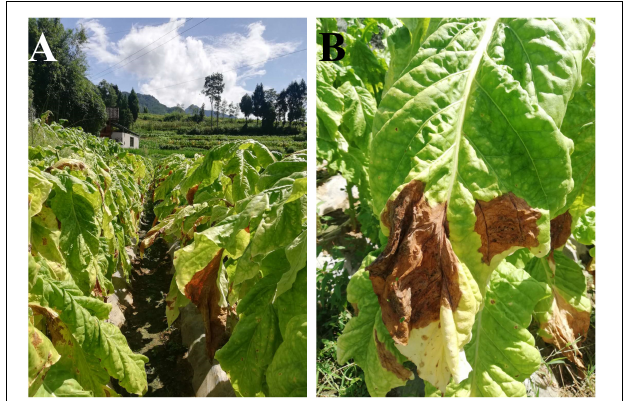
FIGURE 1 | Field symptoms of diseased tobacco plants (A) and leaves (B)